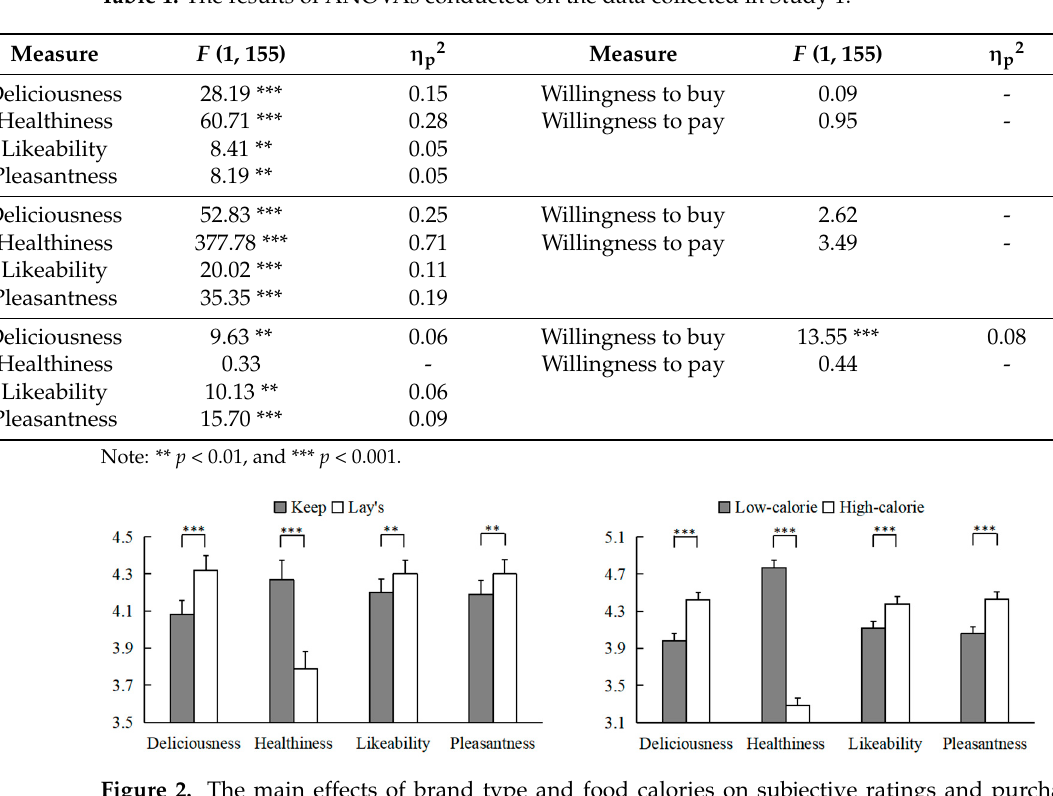
Figure 2. The main effects of brand type and food calories on subjective ratings and purchase intention in Study 1. Error bars show the standard errors of the means. ** denotes p < 0.01 and *** denotes p < 0.001. Table 1. The results of ANOVAs conducted on the data collected in Study 1.